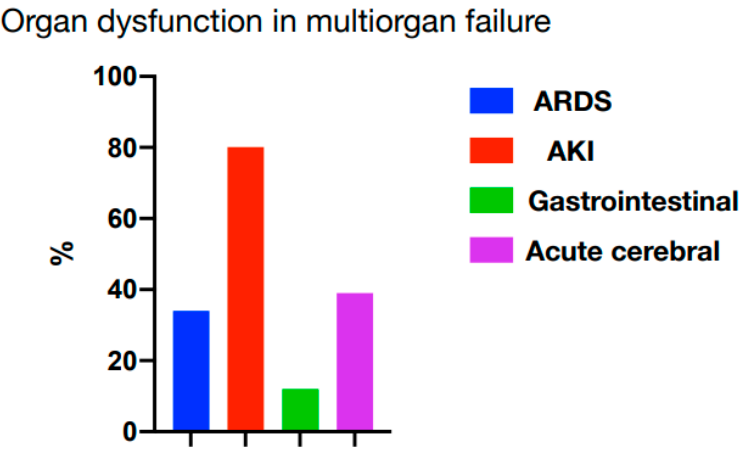
Figure 8. Organ dysfunction in multiorgan failure structure (ARDS—acute respiratory distress syndrome, AKI—acute kidney injury, ).